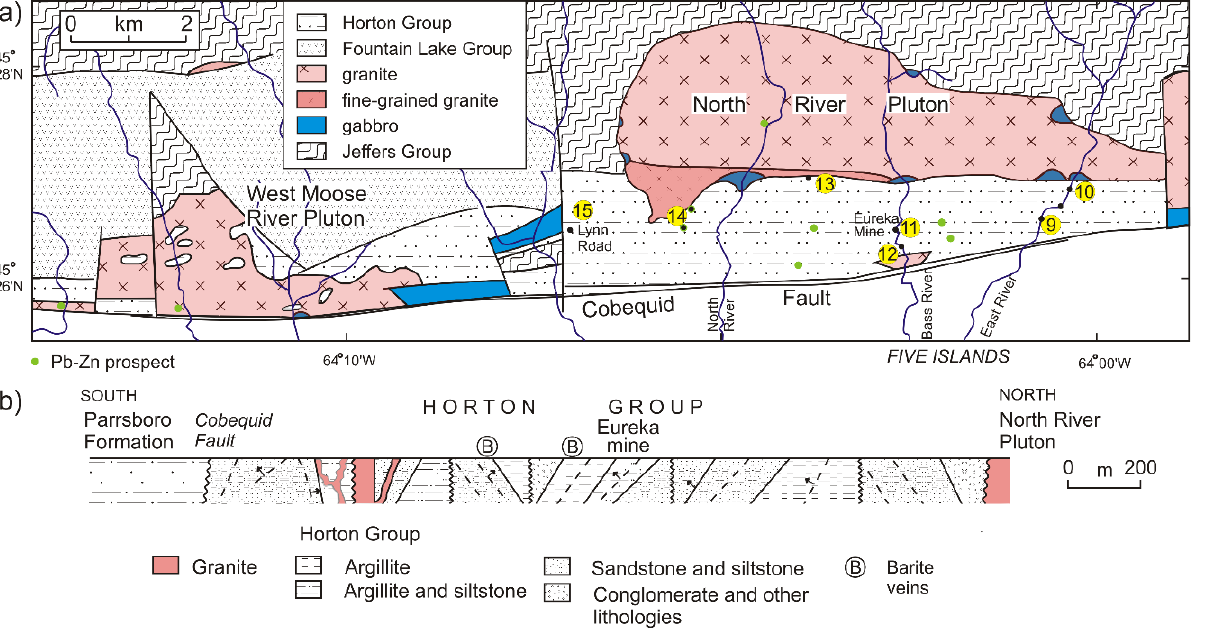
Figure 2. ( a ) Geological map of the area north of Five Islands and ( b ) cross section down the Bass River, showing location of barite mineralization (numbers refer to Table 1). Pb-Zn mineralization from [3] also shown. Base map modified from [14].